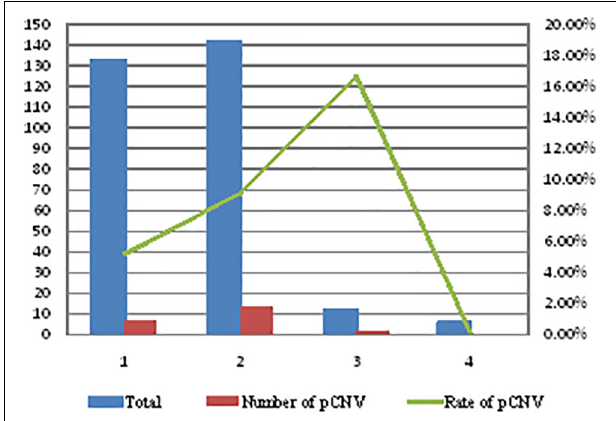
FIGURE 2 | Comparison of the rate of pathogenic CNVs in four types of VM fetuses. 1, mild isolated VM group; 2, mild non-isolated VM group; 3, severe isolated VM group; 4, severe non-isolated VM group; VM, ventricular widening; CNVs, copy number variations; pCNV, pathogenic copy number